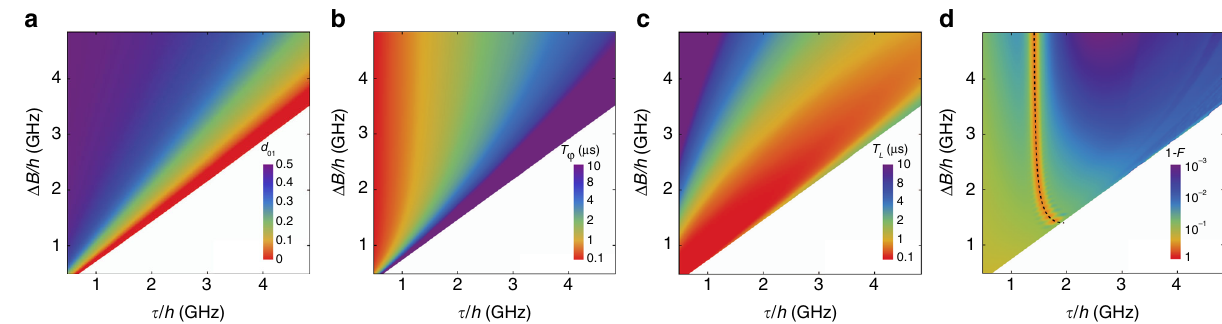
Fig. 3 Qubit properties, evaluated at a TSS, for a range of τ and Δ B . The large white triangles in the lower-right portions of the plots correspond to regions where τ > τ , and no TSS solutions exist. a Dimensionless dipole moment d 01 , which determines the strength of the transverse coupling. When crit τ (cid:5) Δ B , d : 5 because the TSS occurs near the S ð 1 ; 1 Þ – S ð 0 ; 2 Þ transition where the qubit is charge-like, while at τ ¼ τ , d 01 is in the range of 01 (cid:3) 0 crit 10 (cid:1) 3 -10 (cid:1) 4 . b - d Effects of 1 = f -type detuning charge noise. b Dephasing times. Here, T φ is mainly determined by the width of the sweet spot, which is minimized for TSS near the charging transition (Fig. 2b). c Leakage excitation times. Leakage is maximized when τ (cid:3) Δ B , because E 1 L (cid:3) E 01 (Fig. 2c). d AC-driven, single-qubit X π gate fi delity, including all the decoherence mechanisms considered in this work. The dashed line corresponds to the qubit- cavity resonance condition, ω q ¼ ω r ; fi delity is suppressed near this line due interference between the AC drive and the cavity mode. Here we assume a constant photon decay rate of κ = 2 π ¼ 0 : 028 MHz in the cavity (corresponding to a resonator quality factor of Q ¼ 10 5 ) 47 . We also assume physically = h ¼ 0 : 5 GHz 54 , g = 2 π ¼ 50 MHz 27 , ω = 2 π ¼ 2 : 8 GHz 47 , and a cavity temperature of 20 mK for realistic driving and resonator parameters given by ε 0 r AC the initial photon state 25